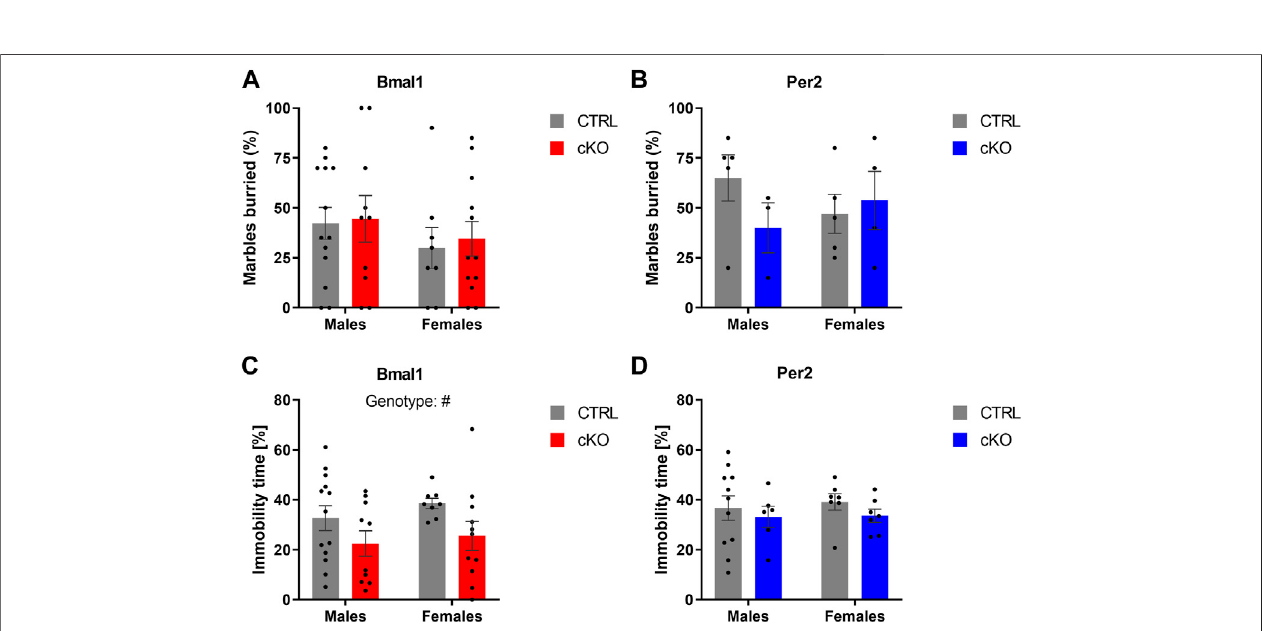
FIGURE 2 | Anxiety- and depressive-like behavior in mice with a conditional Bmal1 or Per2 knockout and control animals. No genotype effects on the number of buried marbles were found in male and female mice of the two mouse lines (n = 3 – 13 per genotype, sex, and mouse line) (A,B) . Depressive-like behavior indicated by immobility time in the tail suspension test is decreased in mice with a striatal Bmal1 knockout (n = 8 – 13 per genotype and sex) (C) but unaffected in mice with a conditional ablation of Per2 (n = 6 – 11 per genotype and sex) from striatal MSNs (D) . Results are depicted as mean ± standard error of the mean (S.E.M.). # ... p ≤ 0.05, three-way ANOVA. Details of the statistical analysis are shown in Table 2